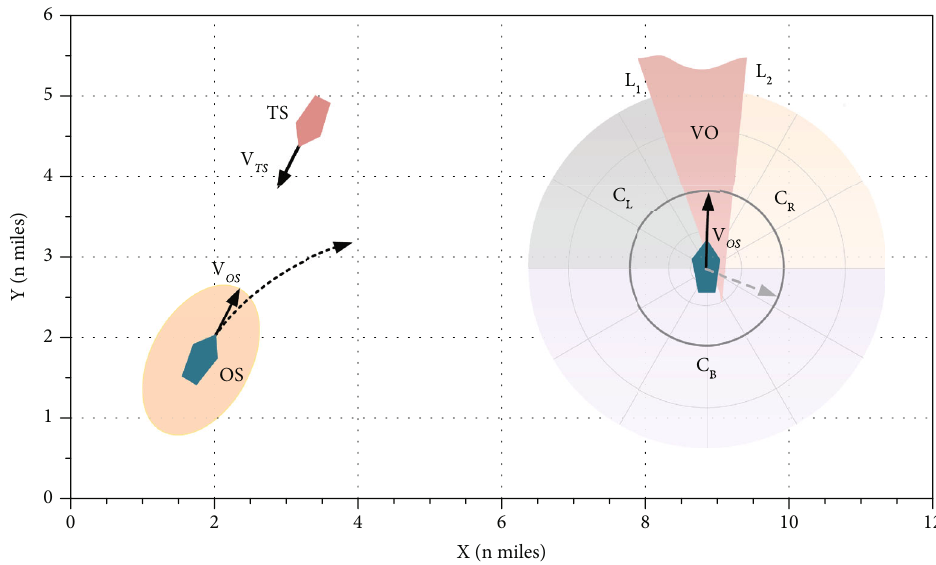
Figure 9: The diagram of collision avoiding in head-on situation.